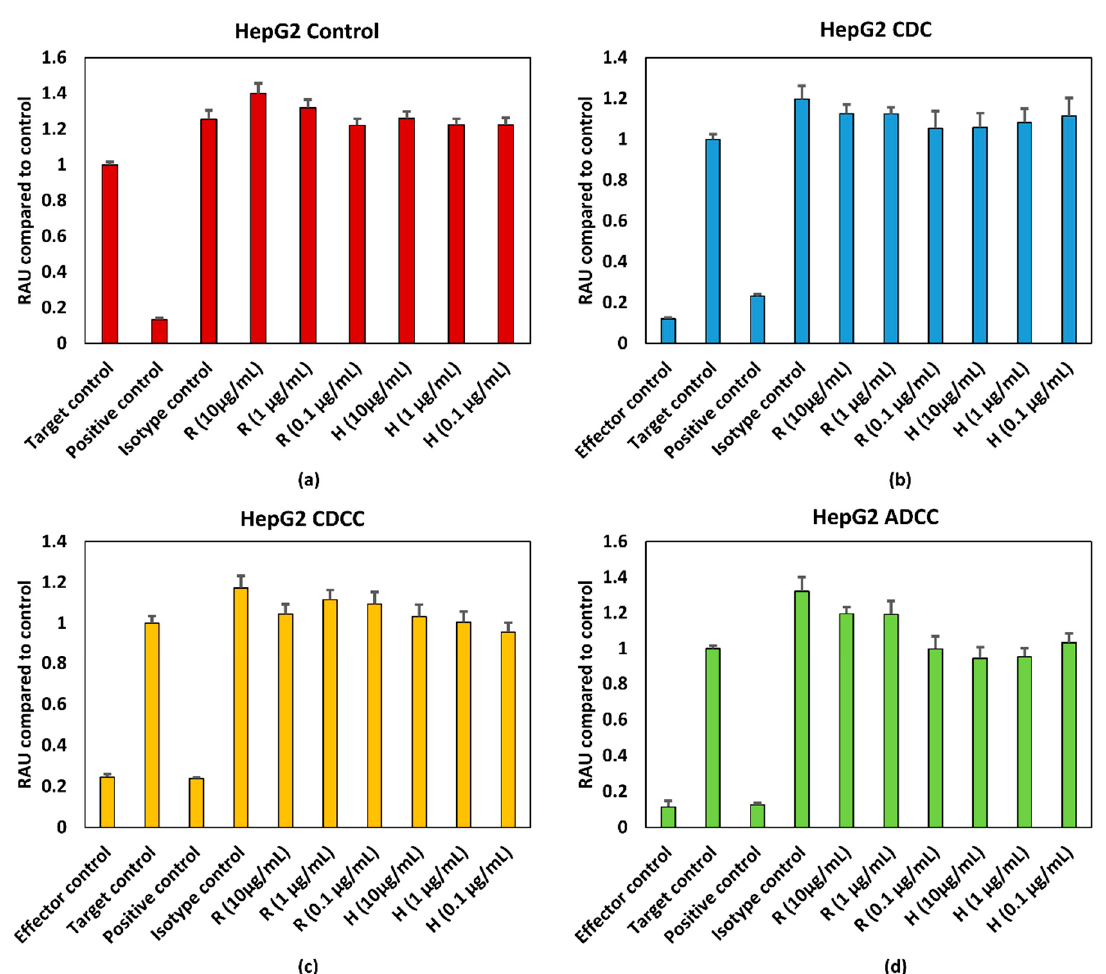
Figure 2. ( a ) Control conditions without effector cells/serum ( b ) CDC ( c ) CDCC, and ( d ) ADCC assay